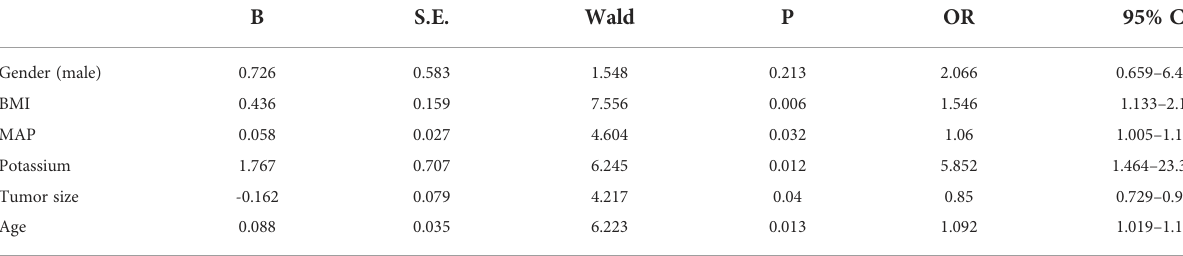
TABLE 3 Predictive factors for incomplete biochemical success: Outcome of multivariate logistic regression analysis.